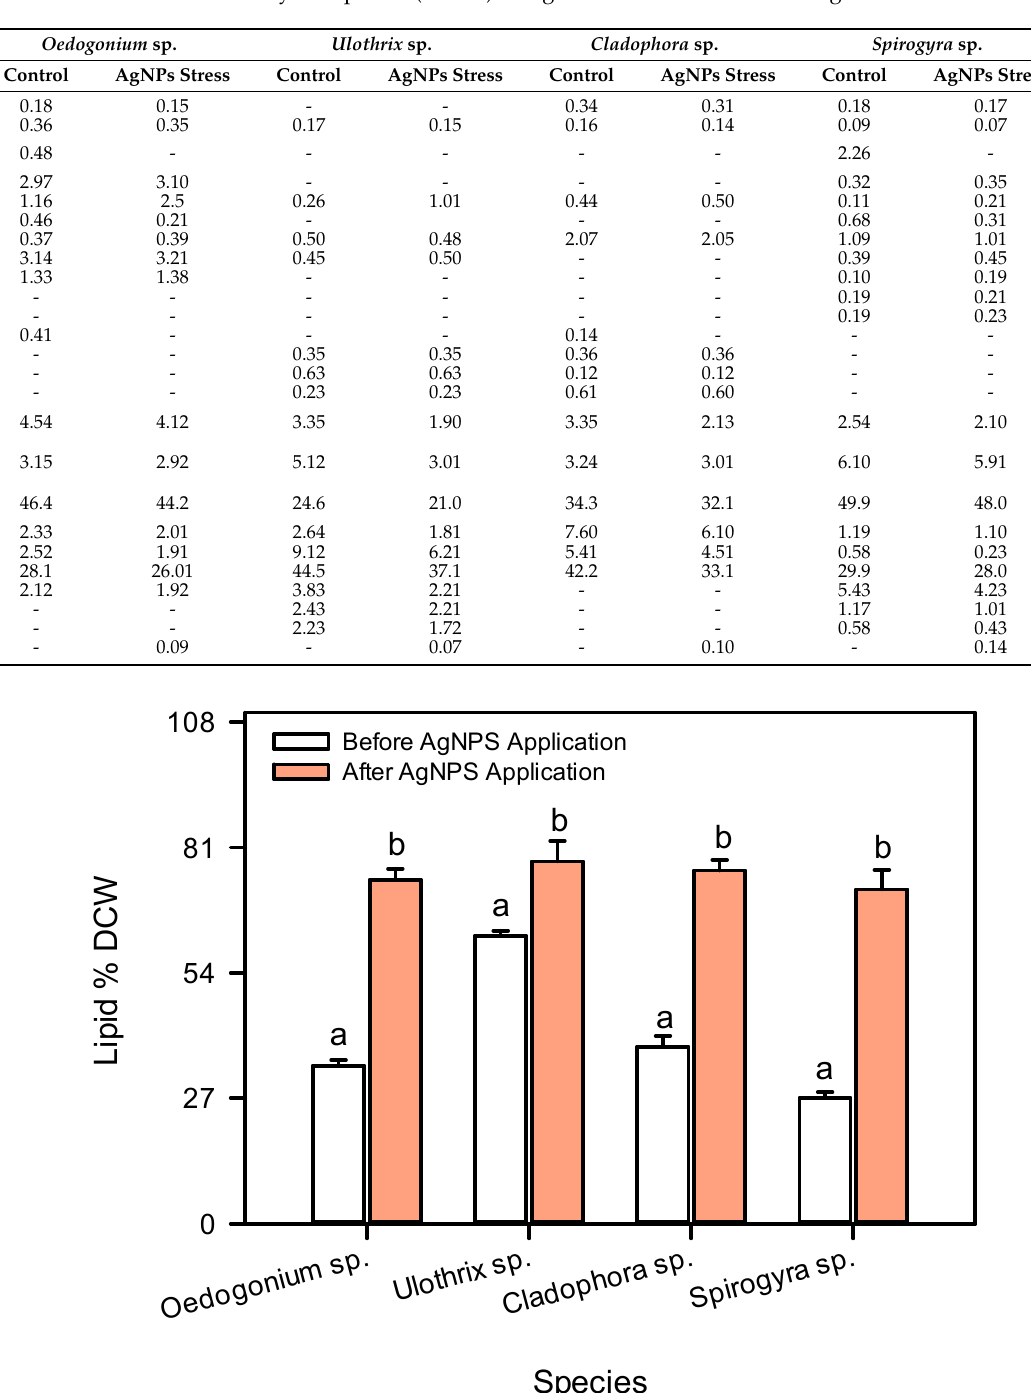
Figure 5. Lipid production yield in studied algal species before and after silver nanoparticle appli- cation. (Different letters show different letters indicate significant difference at P = 0.05 according to Duncan’s new multiple range test. Table 4. GC-MS fatty acid profile (% DW) of algal strains before and after AgNP stress.